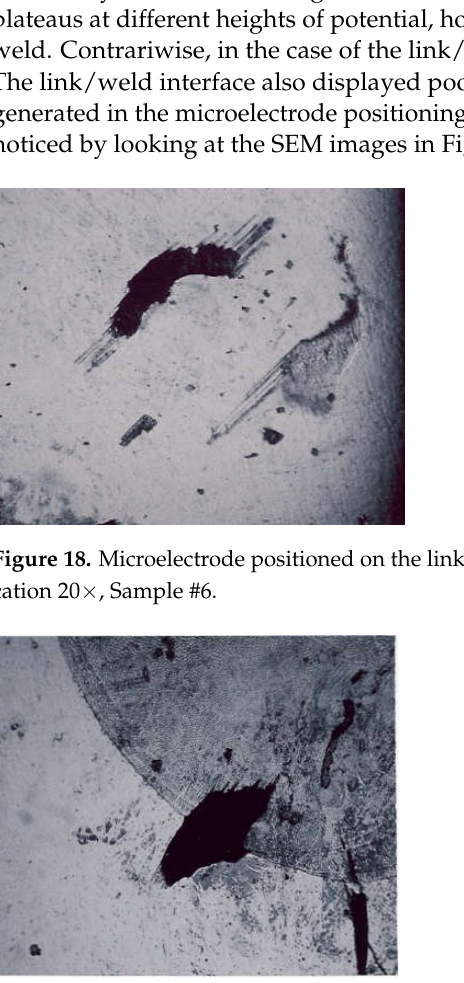
Figure 19. Microelectrode positioned at the link/pin interface. Optical examination, magnification 20×, Sample #6.